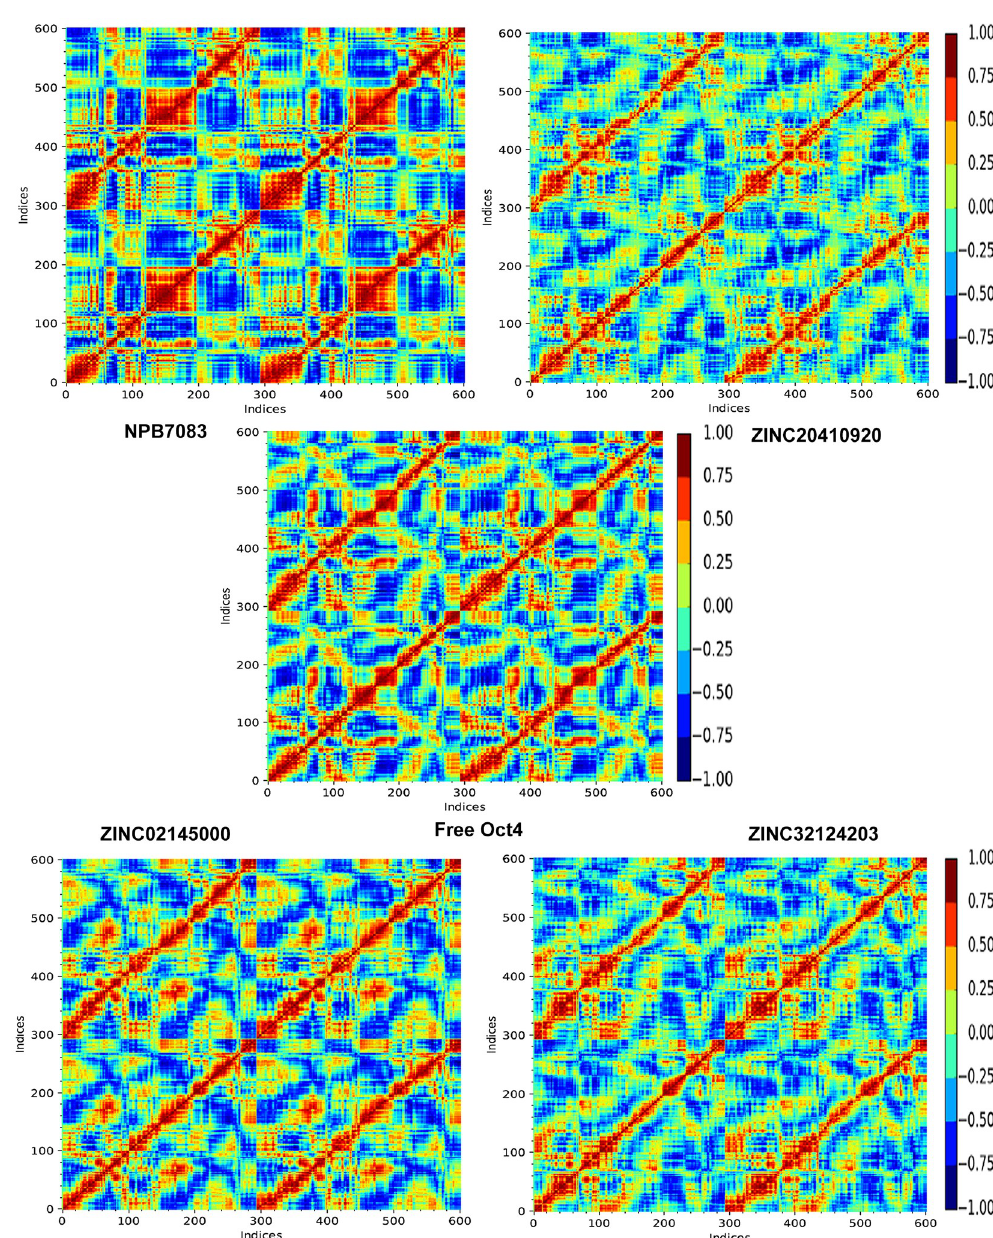
Fig 12. Dynamic Cross-correlation Matrix (DCCM) of the backbone atoms during100 ns simulations. The range of the correlated and anti-correlated motions indicated in various colors in the panel where red color denotes positive correlation and blue color specified negative